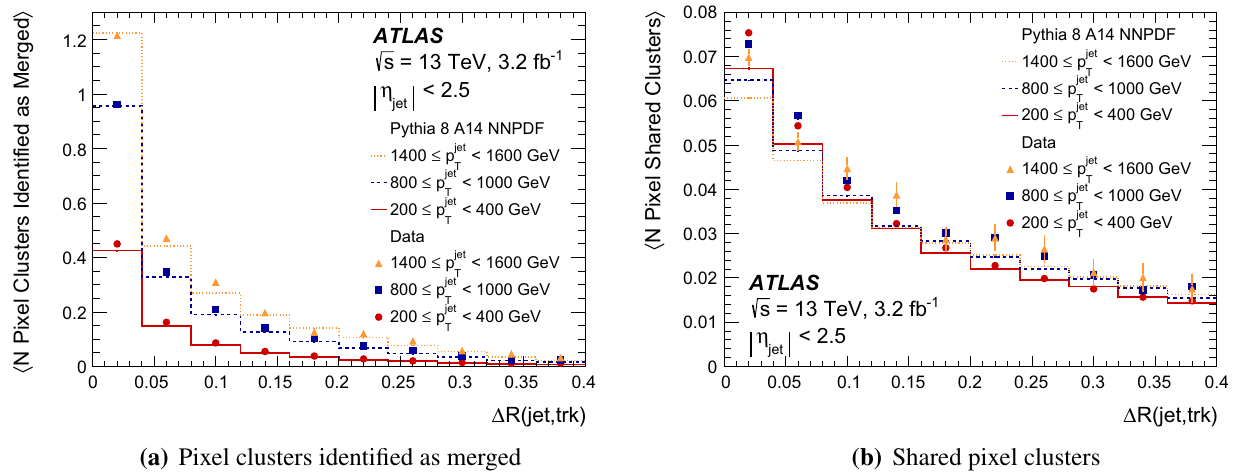
are compared in bins of jet p T . The rise in both populations at small distances from the jet axis is expected due to the increasingly dense environment